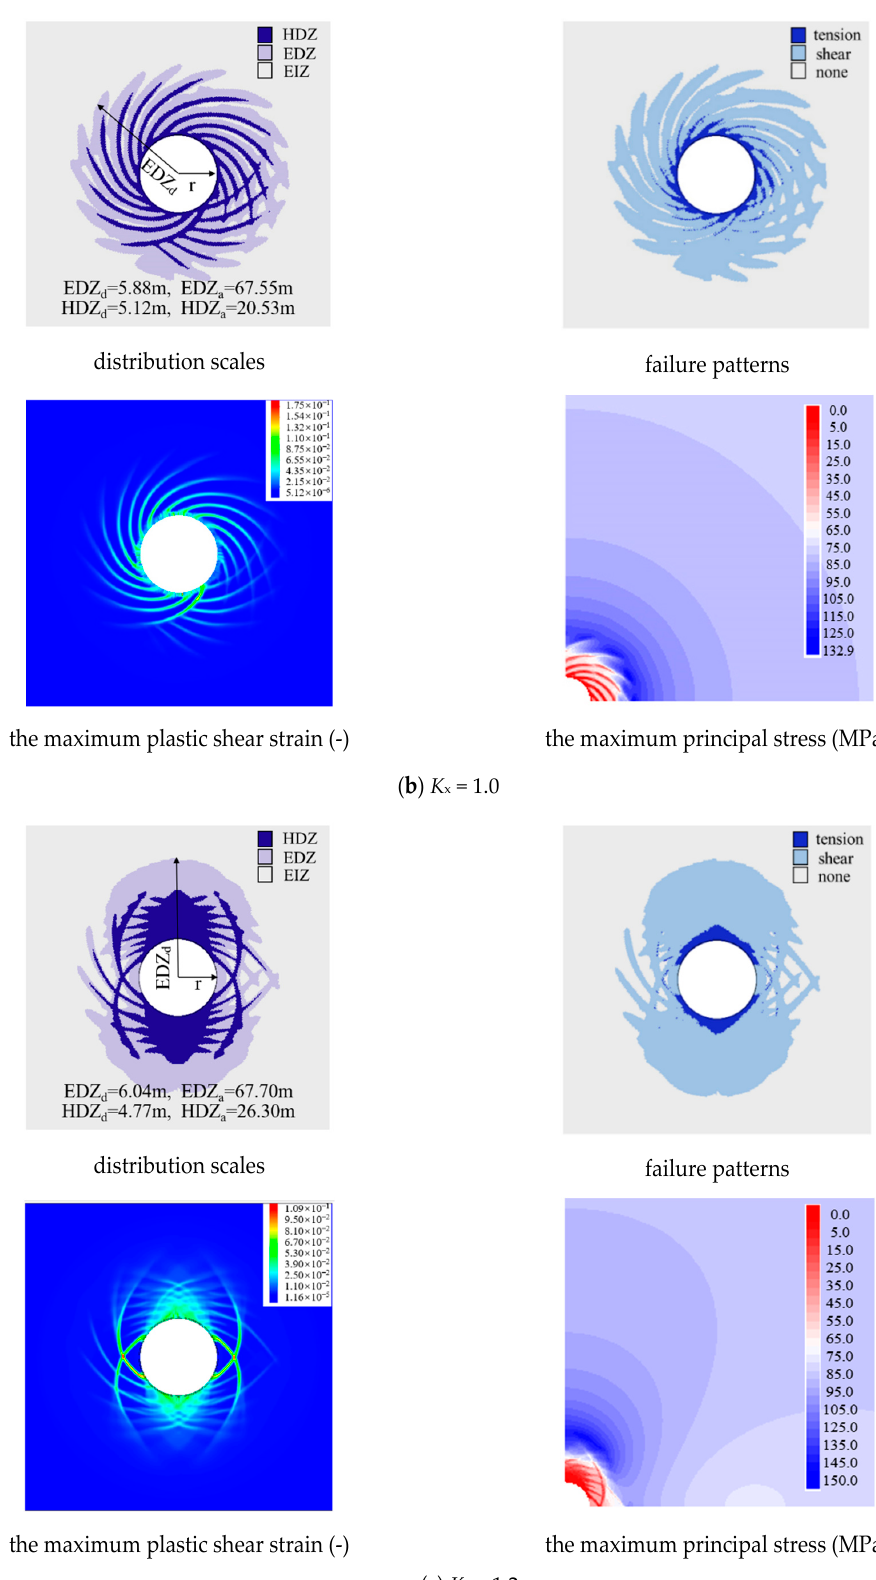
Figure 11. Effect of various coefficients of lateral pressure on